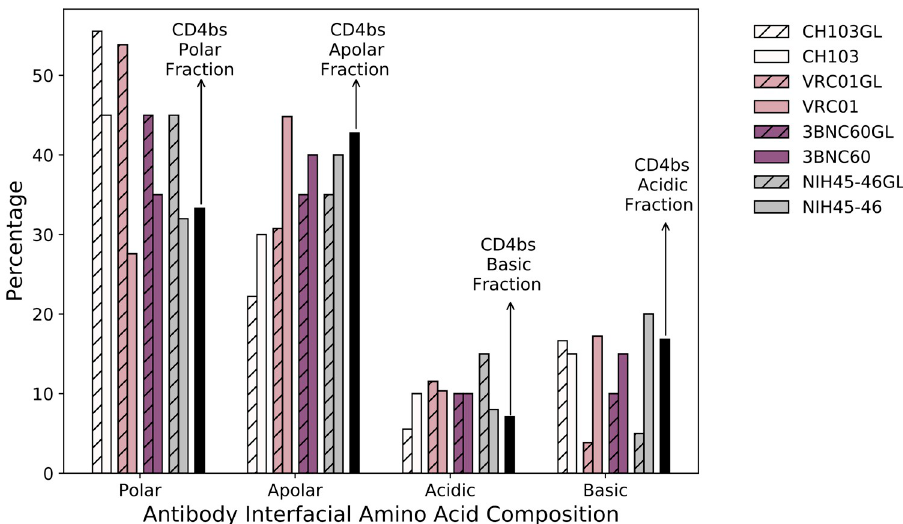
Fig 3. Anti-CD4bs bnAbs employ interfacial composition and electrostatic pattern matching (ICM) during AM. Interfacial amino acid compositions are shown in white (CH103), pink (VRC01), purple (3BNC60), and gray (NIH45- 46), with solid and hatched bars representing the mature and germline forms of the Abs, respectively. For each amino acid type, the Abs’ target interfacial fraction in the CD4bs of HIV is indicated by a black bar (note that the Abs’ acidic interfacial compositions evolve to match the basic interfacial composition of the CD4bs, and vice